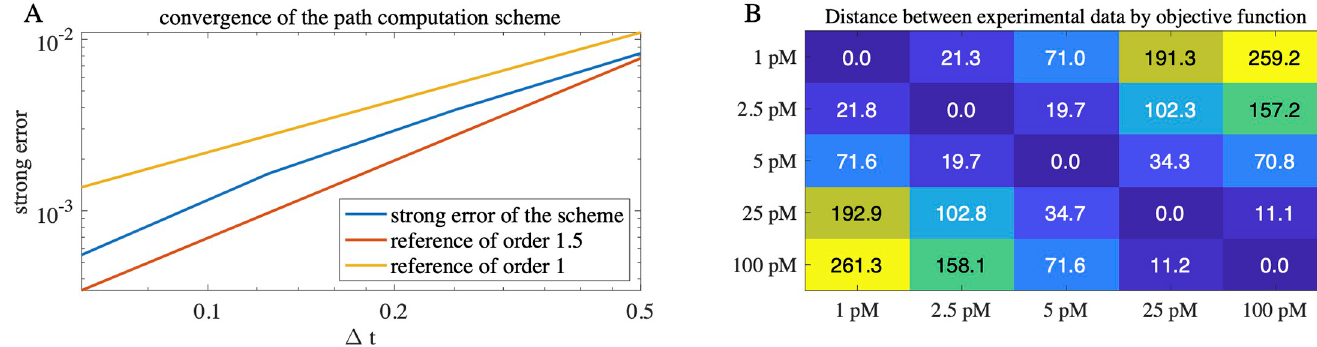
Fig 4. Validation of path computation scheme and cost function. A: Convergence of the path computation scheme. The strong error | E ( X Δ the time increment is shown in loglog scale (blue line). Here X Δ t refers to the approximate model solution computed by the scheme with time increment Δ t . The reference solution X ref was computed with a small Δ t = 0.03 and the maximum norm over time was chosen in the error computation. The slope in the graph corresponds to the strong order of convergence. While for larger time increments the scheme exhibits an experimental convergence order only slightly larger than one (yellow line), this order increases to approximately 1.5 for small time increments (red line). Thus, the high order of the scheme is verified (opposed to the commonly used Euler-Maruyama scheme of strong order 0.5) and accurate numerical integration is ensured for small time increments. B: Sensitivity of the objective function with respect to the dose of TGF- β . Single-cell data from experiments with different doses of TGF- β was compared using our objective function (see Fig 3). The computed function values (indicated by numbers and color code) show that the objective function increases gradually as the difference in dose increases.